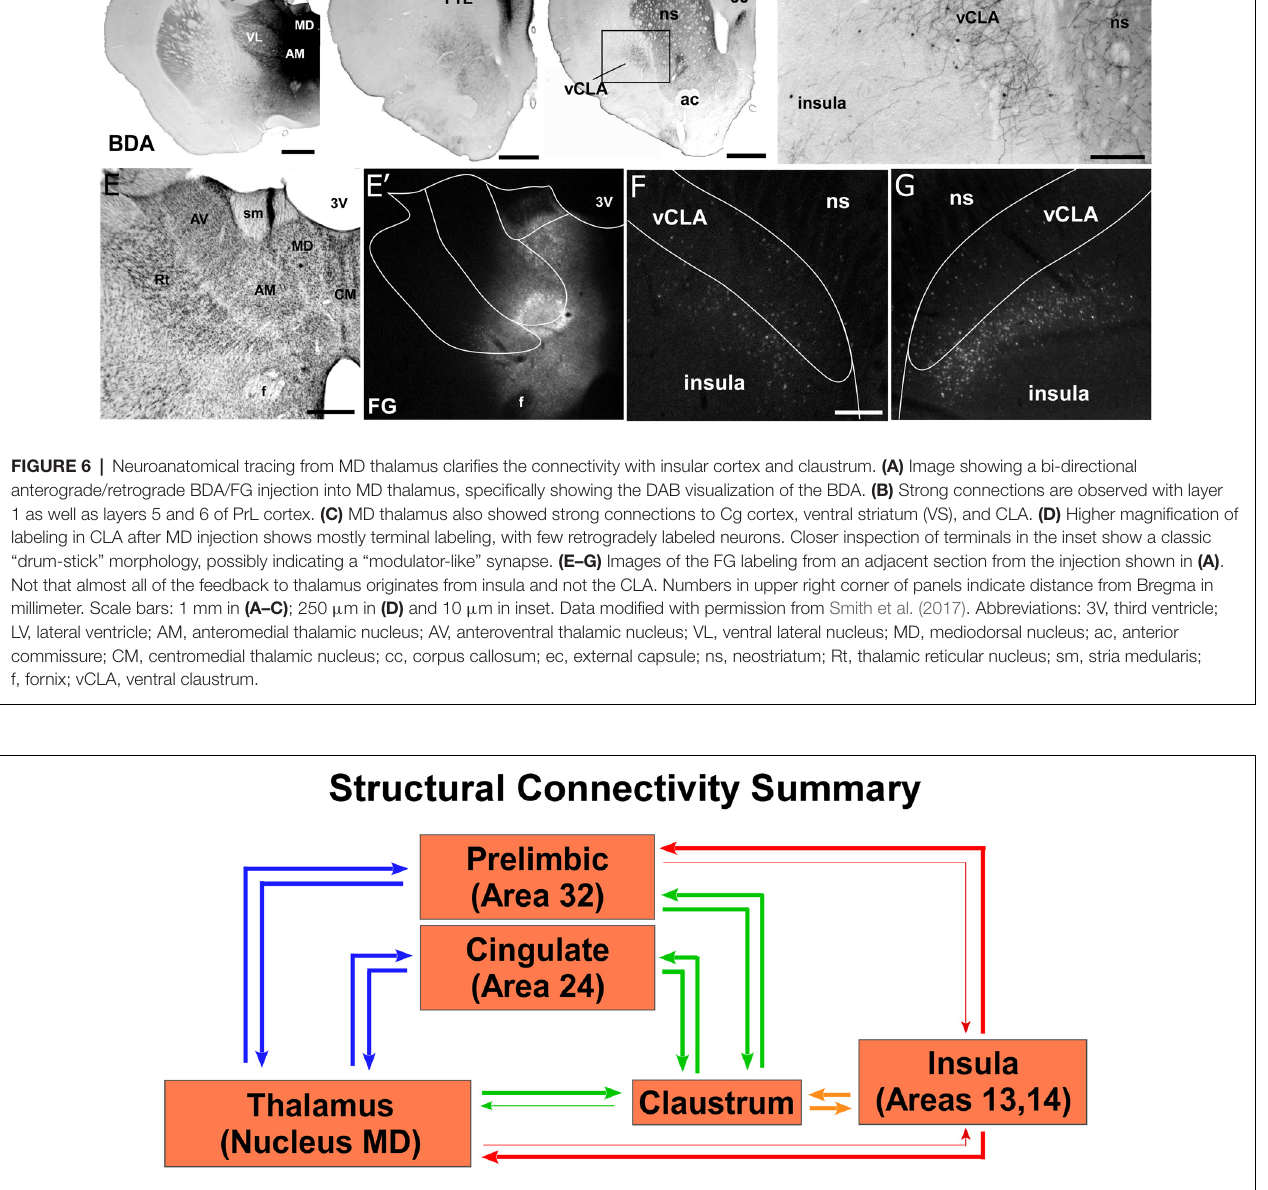
FIGURE 7 | Summary circuit diagram of anatomical connectivity differences between, insula, CLA, PrL, Cg, and MD thalamus. Arrow thickness indicates strength of connection. Parentheticals refer to Brodmann area